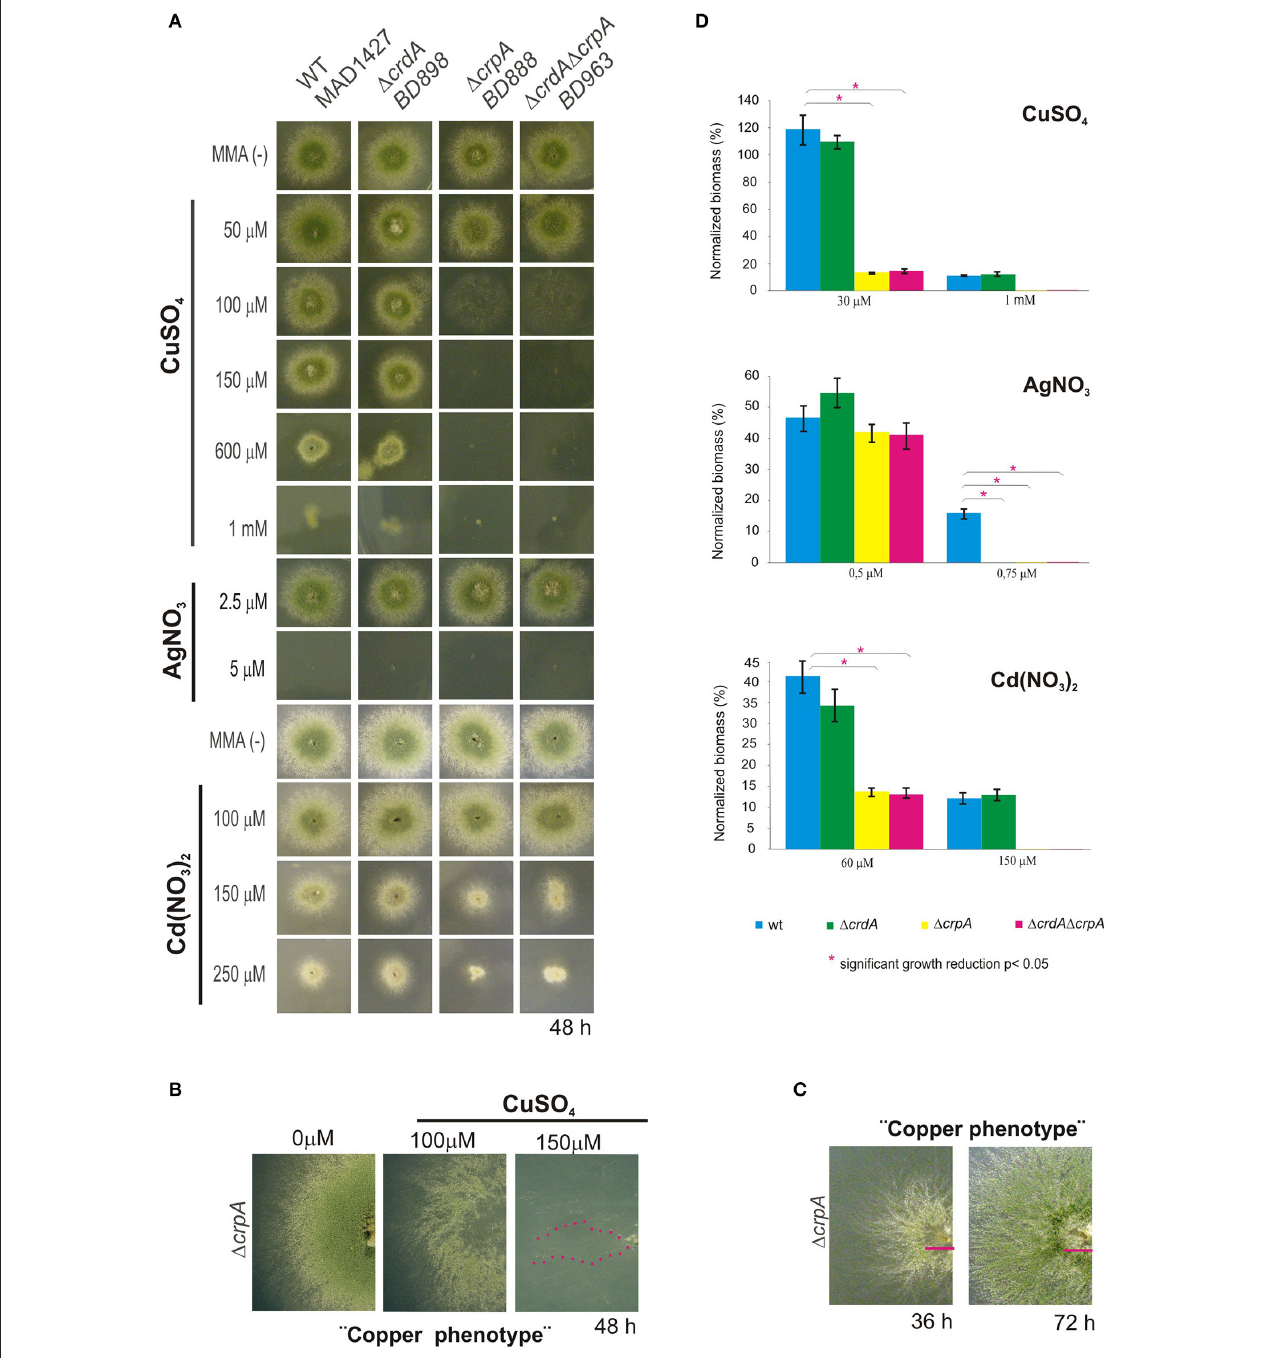
FIGURE 2 | Phenotypic analysis of crpA and crdA mutant strains. Spores of strains having the indicated relevant genotypes were point-inoculated on standard MMA. Images of colonies were taken after 2 days of incubation at 37 ◦ C. (A) Mutant characterization in solid medium supplemented with indicated concentrations of metal salts (B) Close-up views of the morphological colony alterations in the central region of the colony caused by the deletion of crpA when exposed to 100 µ M CuSO 4 , denominated “Copper phenotype.” At 150 µ M CuSO 4 isolated hyphae were observed (magenta dotted line). (C) Recovery of cellular growth in the central region of the colony over the time (magenta lines). Images of colonies were taken after 36 and 72 h of incubation. (D) Cellular growth in liquid MMA was monitored by determining the dry weight (biomass) of cells grown 24h at 37 ◦ C with the indicated concentrations of metal salts. In order to facilitate data comparison growth of each strain at basal level (no stress) was designated 100%, data was normalized and presented as percentages. Graphs show the means ± standard deviation ( SD ) of triplicate experiments ( n = 3). *Significant growth reduction p <